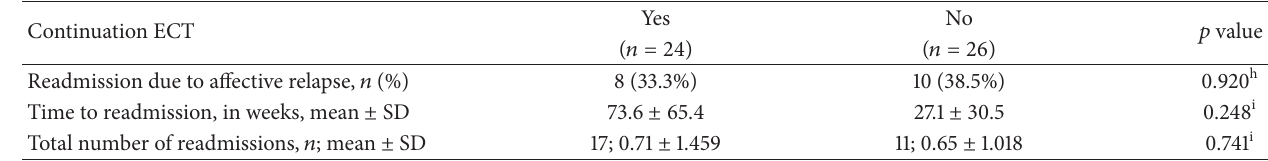
Table 3: Readmission characteristics of episodes that were treated or not treated with cECT ( 𝑛 = 50 ). Continuation